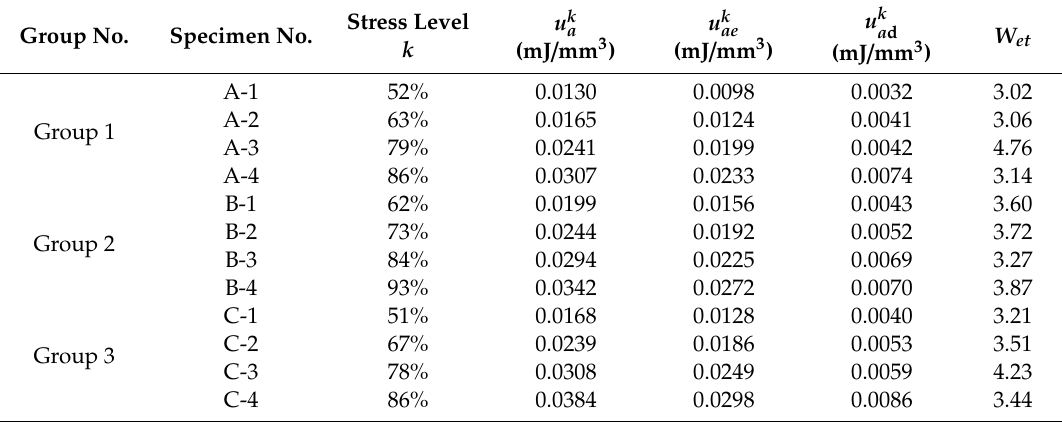
Table 2. Strain energy density of coal specimens in PJ coal